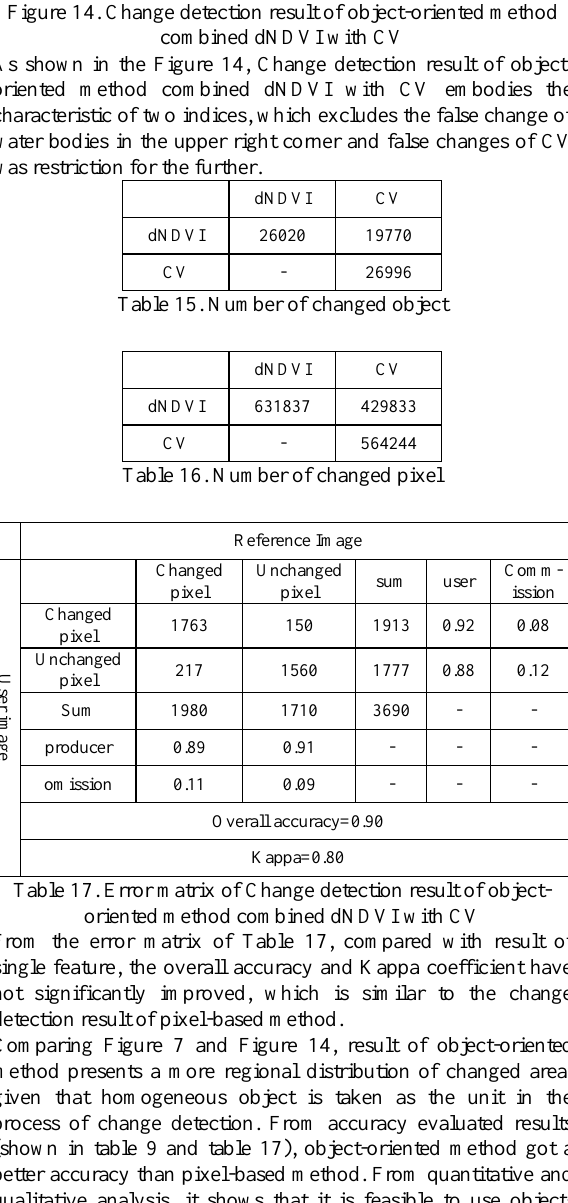
Figure 14. Change detection result of object-oriented method combined dNDVI with CV